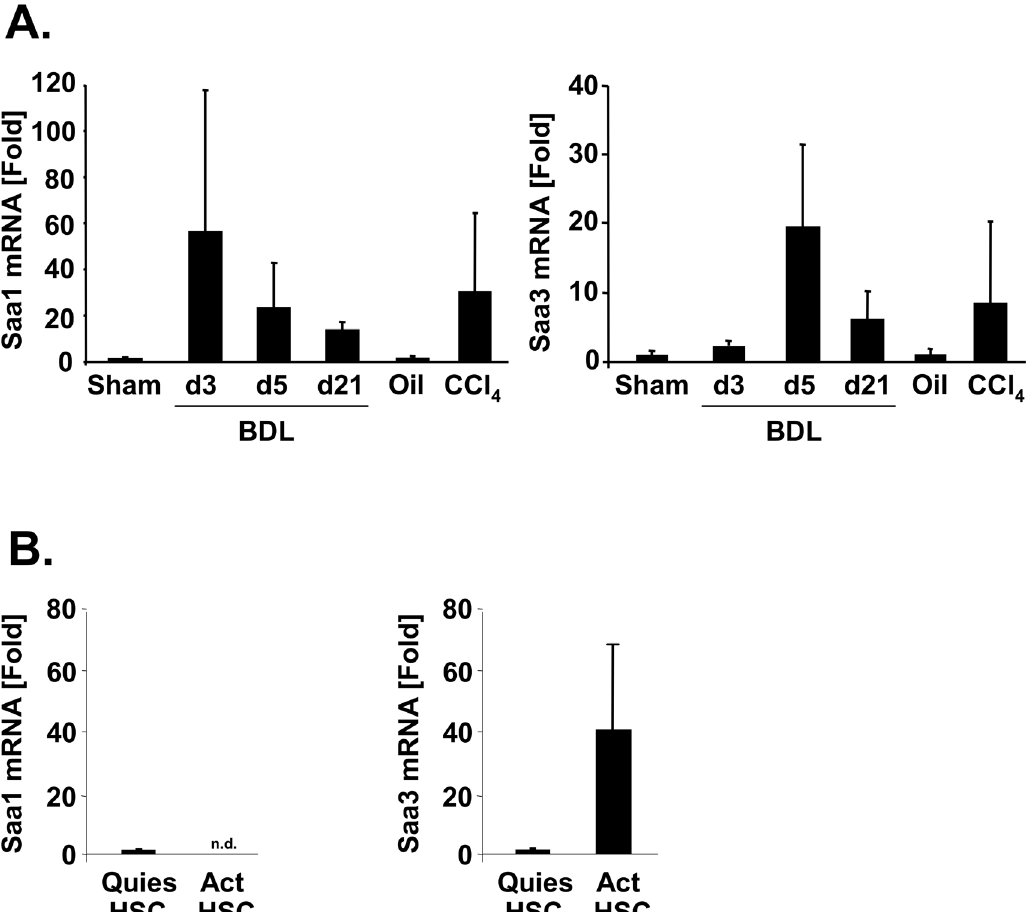
Fig 6. SAA1 and SAA3 levels are elevated during hepatic fibrogenesis. A. Hepatic fibrosis was induced in 8 week old Balb/c mice by bile duct ligation (n = 3 mice per time point) or by treatment with CCl 4 (8 injections of 0.5 μ l CCl 4 /g body weight, dissolved in olive oil, every 3 days, n = 4 mice/group). Following RNA extraction and reverse transcription, mRNA levels of SAA1 and SAA3 were determined by quantitative real time PCR. Levels are expressed as fold-induction in comparison to sham or oil control mice after normalization to 18s. B. RNA was isolated from quiescent mouse HSCs (18 hours after plating, n = 3 independent isolations) or activated mouse HSCs (5 days after plating, n = 3 independent isolations). mRNA levels of SAA1 and SAA3 were determined by quantitative real time PCR. Levels are expressed as fold-induction in comparison to quiescent HSCs after normalization to 18s.